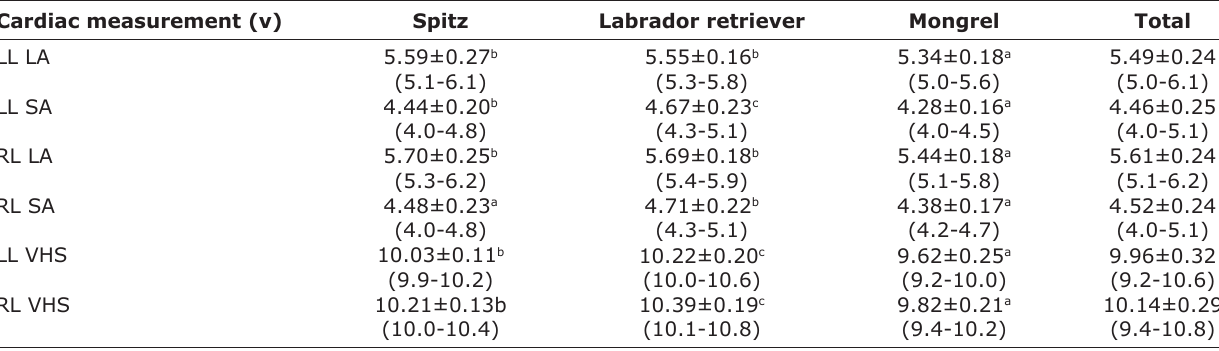
Table-1: Mean (±SD) of cardiac measurements in Spitz, Labrador retriever and Mongrel dogs. Cardiac measurement (v) Spitz